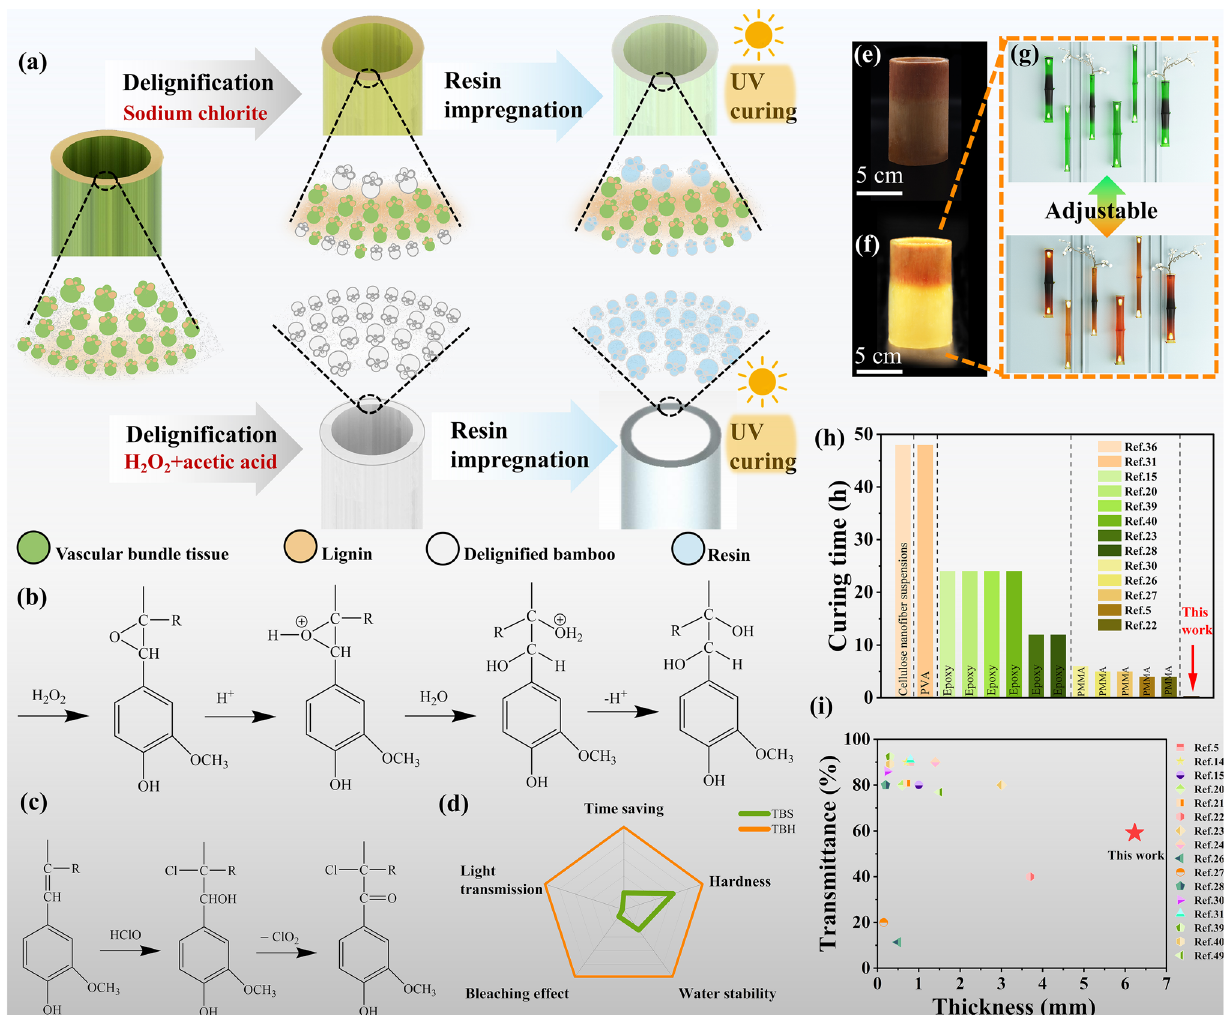
Fig. 1 a Schematic illustration of the preparation of cellulose composites by different delignification methods. b Reaction of lignin in a mixed solution of hydrogen peroxide and acetic acid. c Reaction of lignin in acidic sodium chlorite solution. d Radar plot showing the comparison between TBS and TBH. e Macroscopic view of TBS. f Macroscopic view of TBH. g Applications of TBH in lighting materials. h Comparison of curing time of our work and other biomass transparent materials impregnated by different polymers. i Comparison of thickness of our work and other biomass transparent